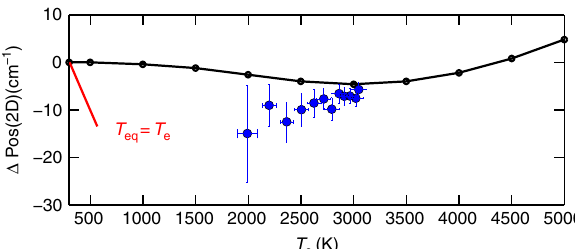
Fig. 7 Temperature dependence of Pos(2D). Pos(2D), relative to the RT CW measurement, as a function of T e . Black line: DFPT; blue circles: experimental data with pulsed excitation. Red line: T-dependent CW measurement in thermal equilibrium ( T e = T l = T eq ) from ref. 72 . The error bars represent the 95% of con fi dence level, as in